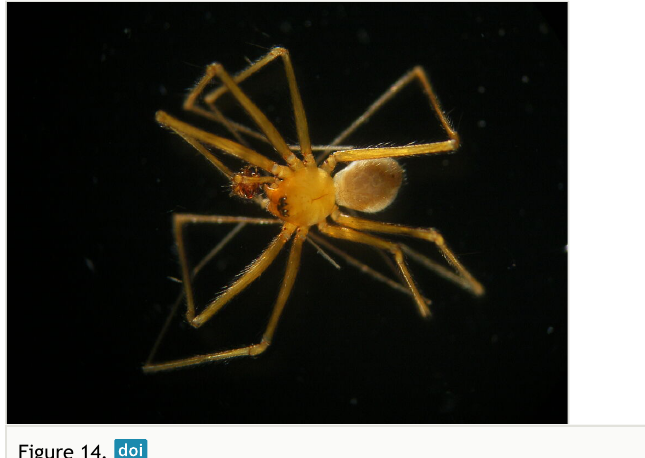
Figure 14. Troglohyphantes tauriscus Thaler, 1982. Photo credit: Christian